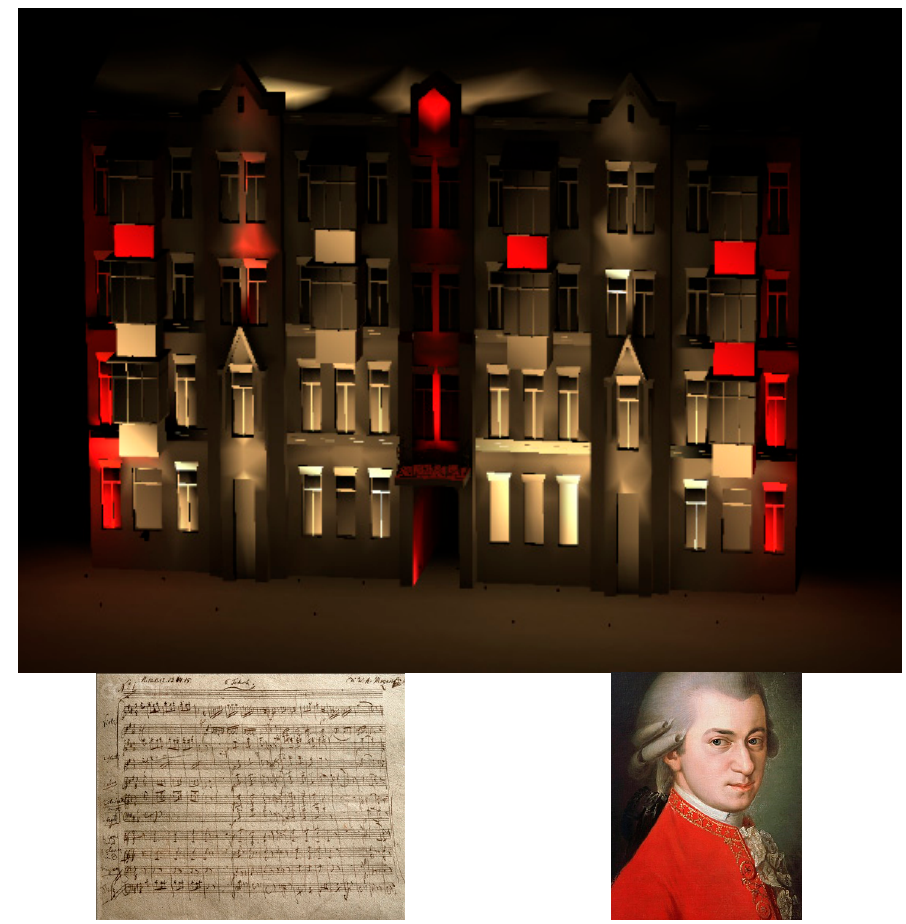
Figure 24. Seasonal façade lighting for Mozart’s work ( top ) inspired by the two pictures ( bottom ) [84,85].